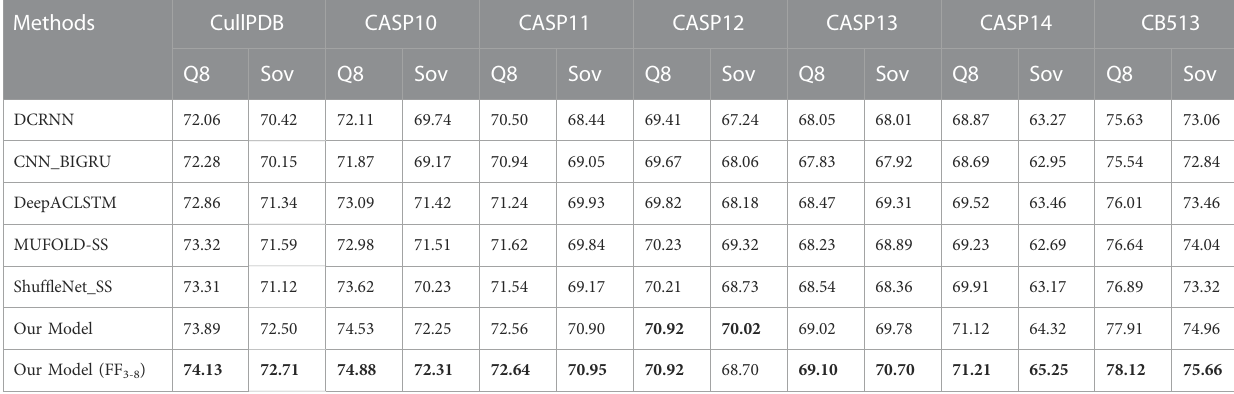
TABLE 6 8-state PSSP performance comparison with state-of-the-art methods on seven datasets. Bold indicates the best performance. Methods